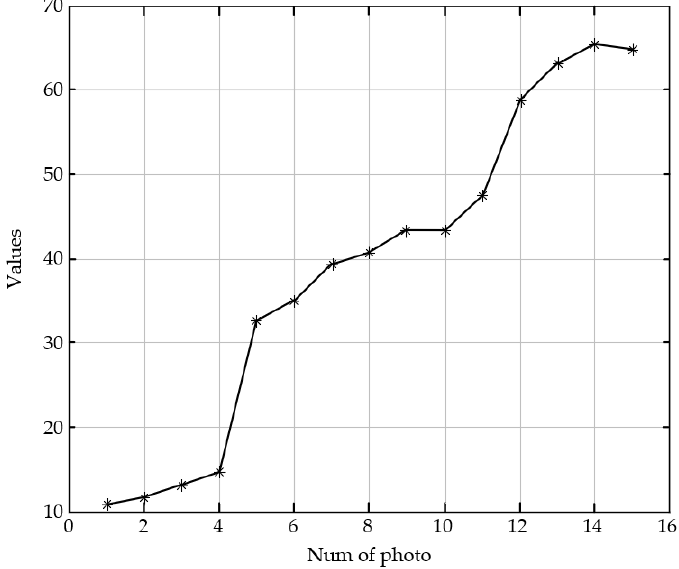
Figure 6. Evaluation scores of the image sequence in Figure 4 with the SVM model.